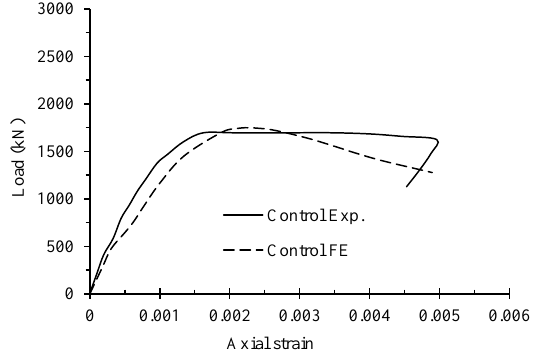
Figure 12. Comparison of load versus axial strain curve for control column.